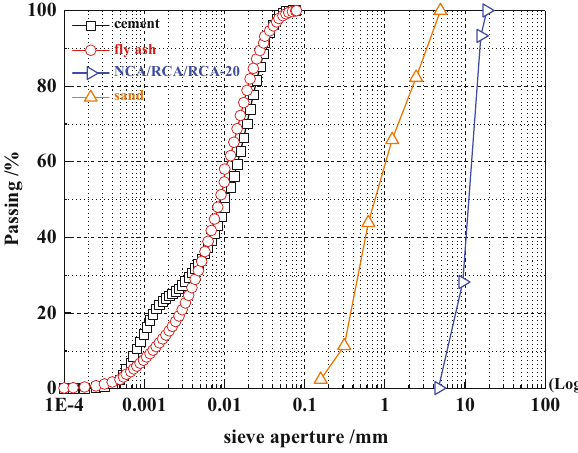
Figure 2: Particle size distribution of coarse aggregate, sand, cement, and fl y